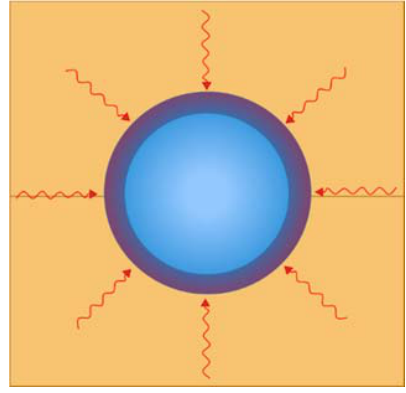
Figure 5. Temperature change test schematic.